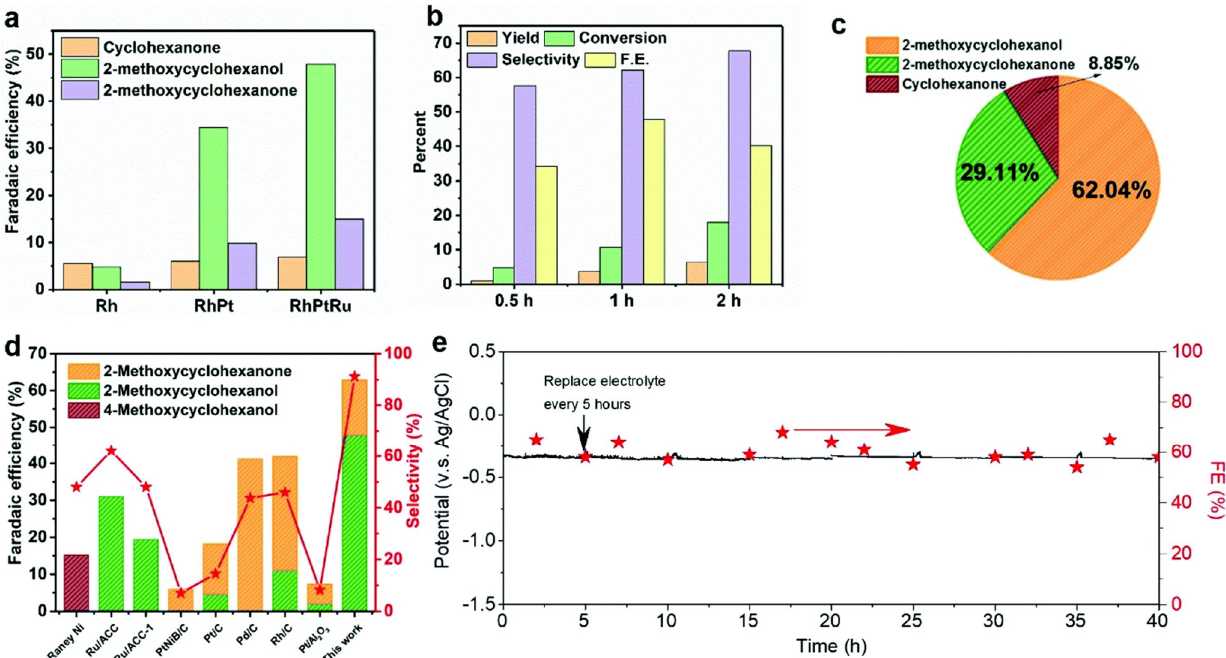
Figure 7. ( a ) Faradaic efficiency (FE) toward various hydrogenated products from guaiacol using Rh, RhPt, and RhPtRu catalysts at 50 mA cm − 2 after 1 h electrocatalytic reaction. ( b ) Yield, conversion, selectivity, and FE towards 2-methoxycyclohexanol obtained by upgrading guaiacol using a RhPtRu catalyst at 50 mA cm − 2 for up to 2 h. ( c ) Pie chart with the molar ratio of various hydrogenated products over the RhPtRu catalyst at 50 mA cm − 2 after 1 h electrocatalytic reaction. ( d ) Comparison of Wang et al. [73] with representative research that targeted the preservation of oxygenated functional groups (OFGs, –OCH3) via ECH. Right-Y axis represents the selectivity of methoxylated products over various catalysts. ( e ) The ECH of guaiacol on RhPtRu catalysts at an applied current density of 50 mA cm − 2 using a H-cell system with 50 mL of catholyte for 40 h, showing the potential and FE to the target methoxylated products. Note that the catholyte was replaced every 5 h. Reproduced with permission from ref [73]. Copyright 2022 The Royal Society of Chemistry.